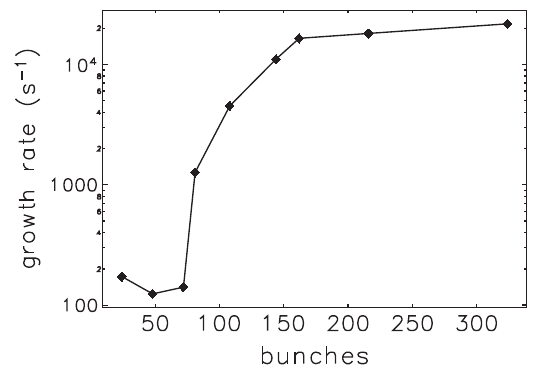
FIG. 11. Instability growth rate as a function of the number of bunches, with 25 mA total beam current and 5 Ah beam